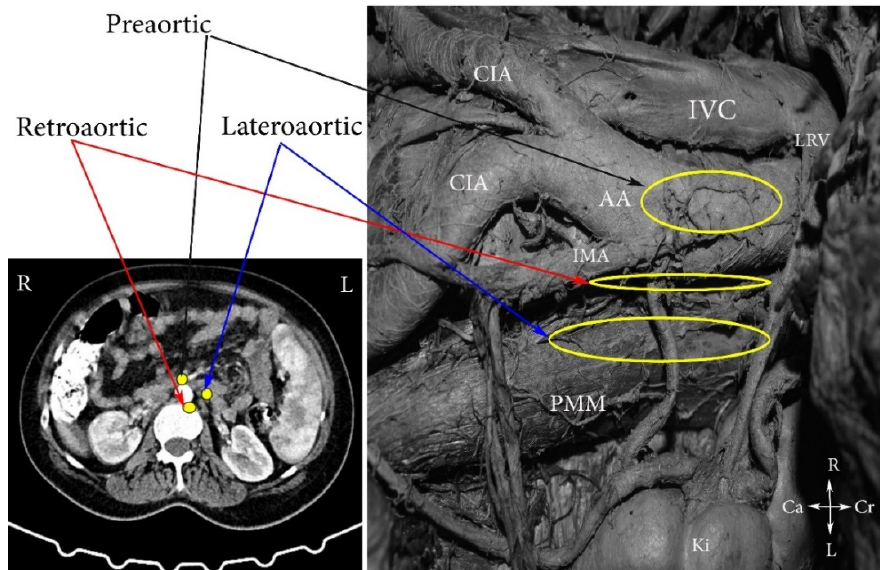
Figure 2. Left lumbar lymph nodes (embalmed cadaver). CIA—common iliac artery, IVC—inferior vena cava, AA—abdominal aorta, PMM—psoas major muscle, LRV—left renal vein; IMA—inferior mesenteric artery, Ki—kidney, Cr—cranial, Ca—caudal, L—left, R—right.